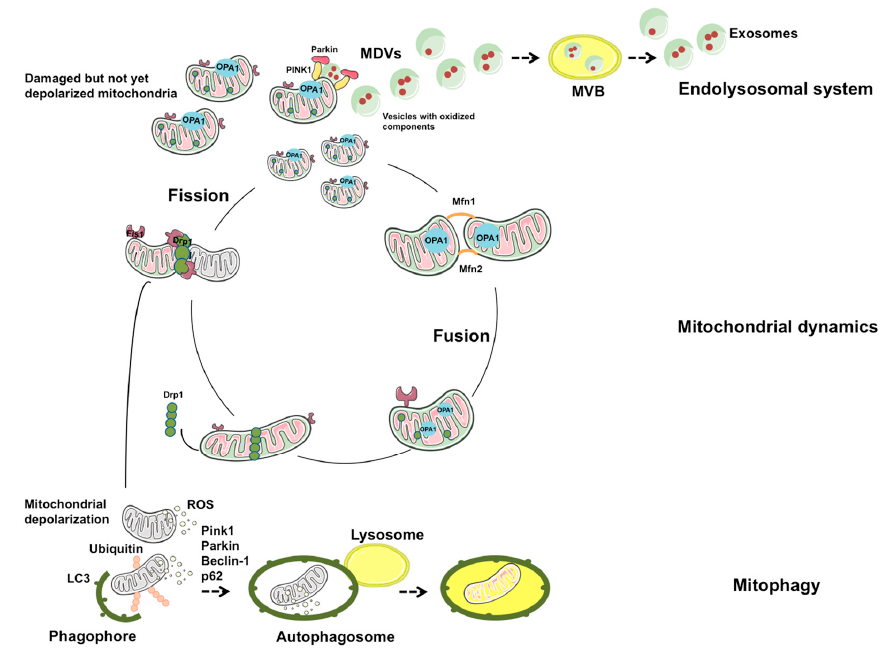
Figure 1. Mitochondrial quality control through mitophagy and mitochondrial-derived vesicle trafficking. Several interrelated processes ensure mitochondrial quality and turnover. Mitochondrial dynamics are mediated by a number of factors that regulate fusion [mitofusin 1 (MFN1), MFN2, and optic atrophy 1 (OPA1)] and fission [dynamin-related protein 1 (DRP1) and mitochondrial fission 1 protein (FIS1)] processes. Fusion facilitates the dilution of damaged mitochondria along the network, while fission targets dysfunctional organelles for their subsequent clearance through mitophagy. Mildly damaged, not yet depolarized mitochondria may be primed by phosphatase and tensin homolog (PTEN)-induced putative kinase 1 (PINK1) and Parkin to generate mitochondrial-derived vesicles (MDVs). MDVs reach out the endolysosomal system forming multivesicular bodies (MVBs) and are released into the extracellular compartment as exosomes. LC3, microtubule-associated proteins 1A/1B light chain 3; ROS, reactive oxygen